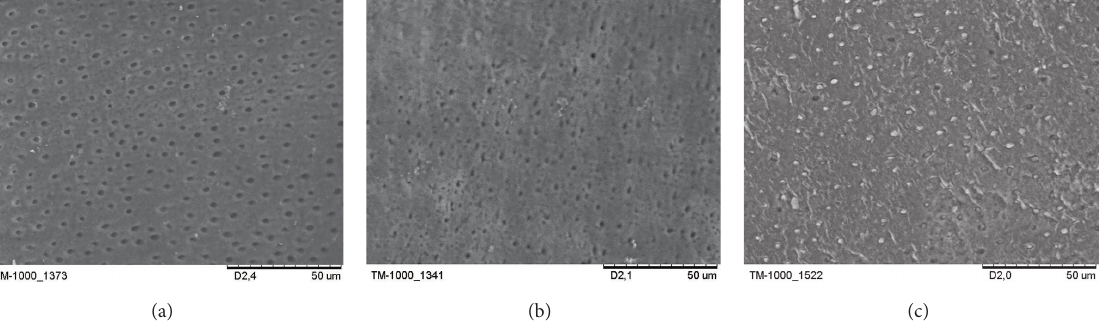
Figure 4: Dentine surface scanning electron microscope (SEM) micrographs. (a) Control group (C), (b) laser only (L − ), and (c) the laser plus nanohydroxyapatite paste (L+). The original magnification was × 1200.